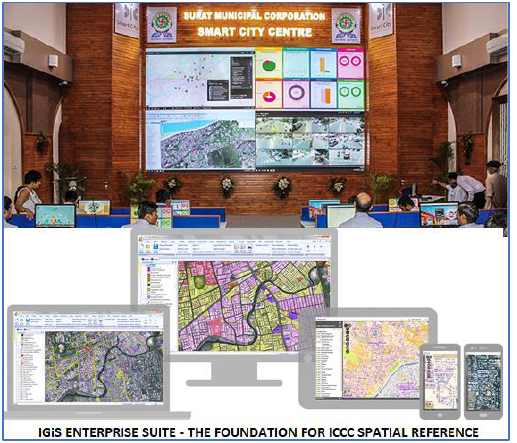
Figure_2: IGiS Enterprise Suite for Spatial Linking